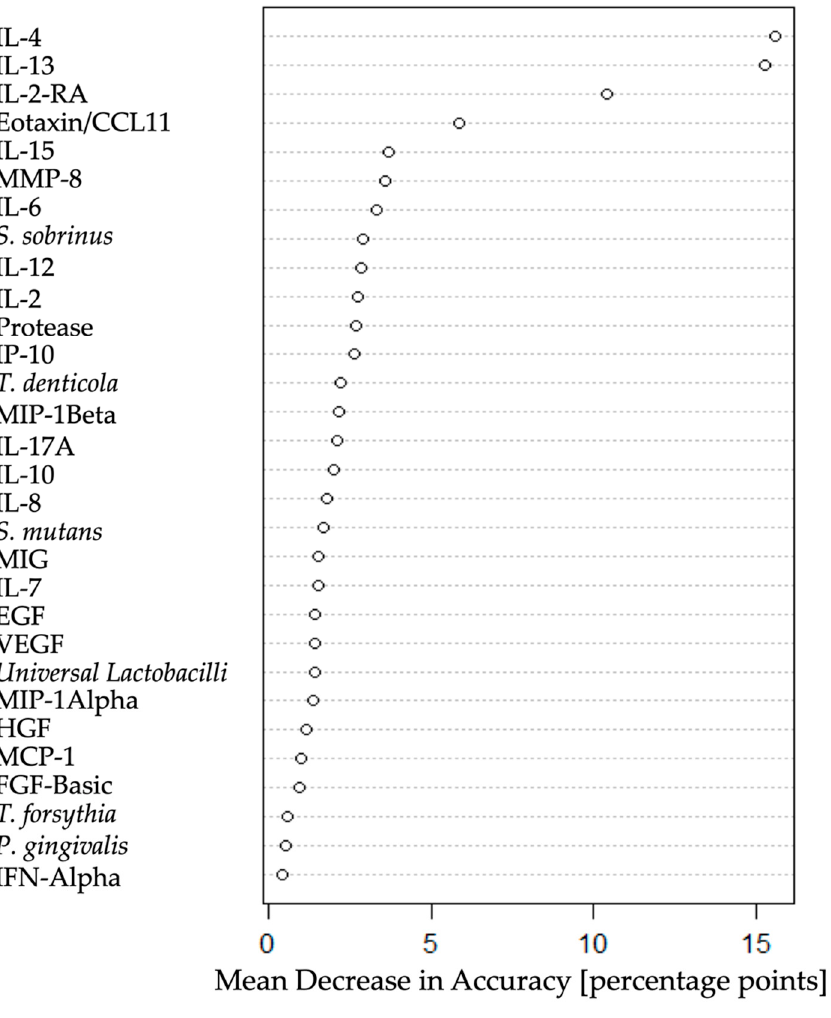
Figure 4. Random forest results plotted according to mean decrease in accuracy, show the strong- est discriminators, namely, IL-4, IL-13, IL-2-RA, and